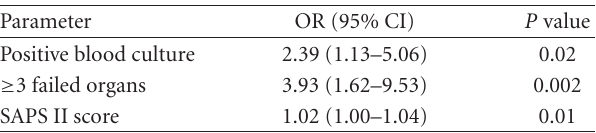
Table 3: Multivariate logistic regression analysis with hospital mortality as the dependent